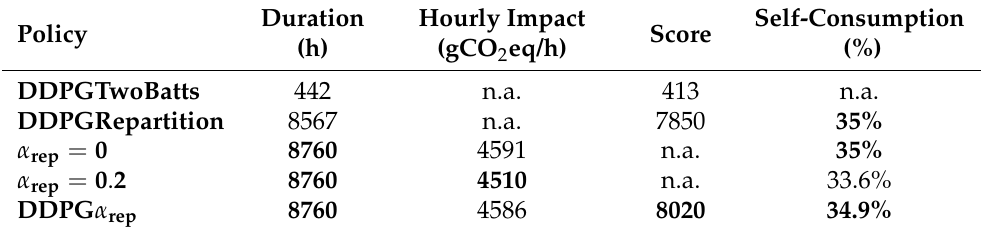
Table 4. Results computed on the year 2007. n.a.: not applicable.